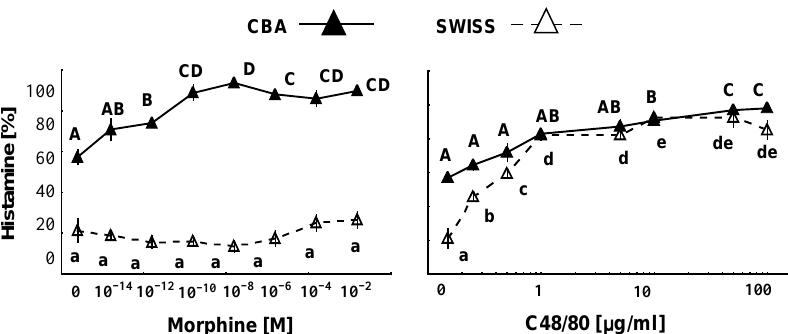
FIG. 2. Invitroeffects of various doses of morphine or C48 u 80 on the percentage of histamine released from peritoneal mast cells of males from CBA and SWISS mice. Data presented as mean 9 / standard error (n (cid:5) / 4). Values sharing at least one letter (e.g. ‘A’ and ‘AB’, ‘a’ and ‘a’, ‘d’ and ‘dc’) do not differ significantly within the group, while values with different letters (e.g. ‘A’ versus ‘B’, ‘c’ versus ‘d’) only vary significantly within the group at p B /